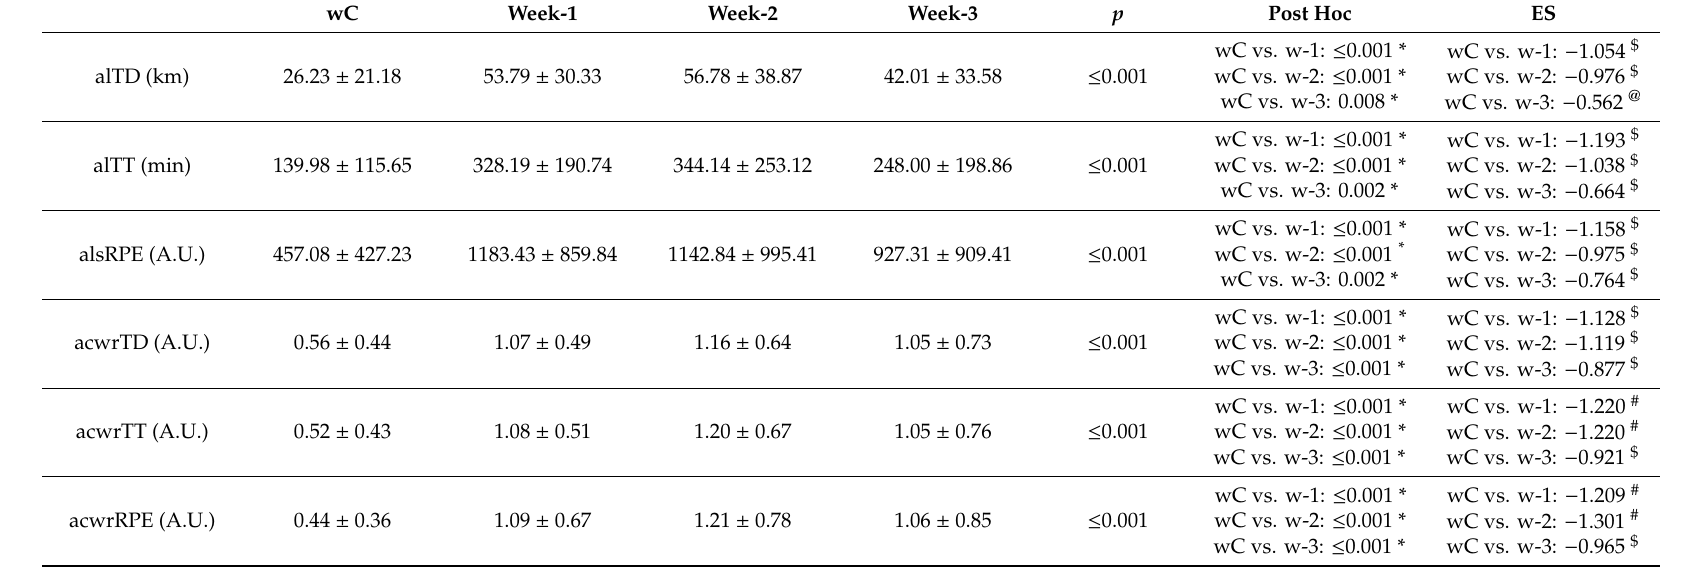
Table 4. Descriptive statistics of workload measures before ultra-trail medium (UT-M)